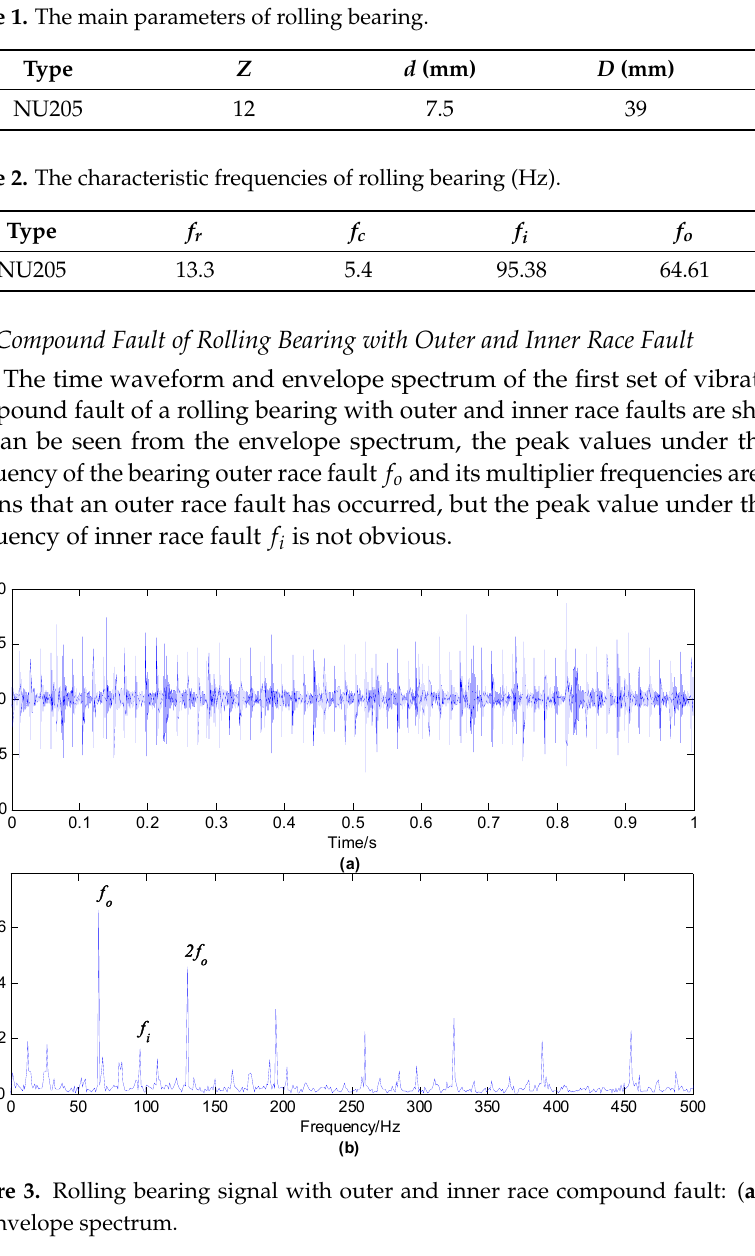
Figure 4. The eight learned basis functions. After that the multiple latent components can be obtained and constructed as a vir- tual 8-channel signal. Then, original FastICA and improved FastICA were employed to separate the source signals, respectively. The source number is 2 and tanh function is utilized as nonlinear function. Through a large number of repeated runs of 26 sets of vi-